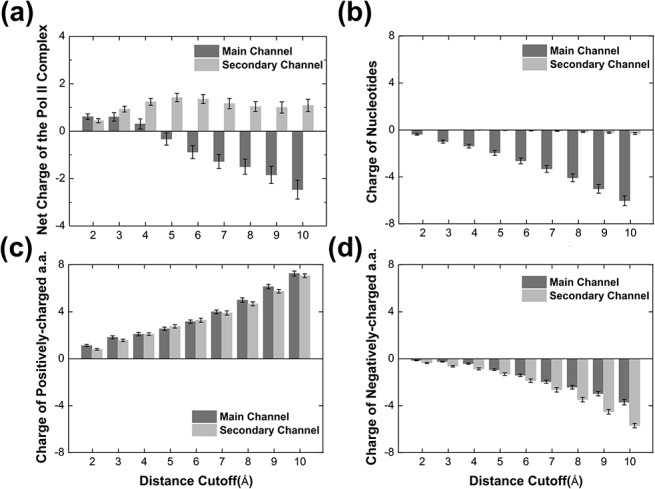
Distribution of charges surrounding the NTP during MD simulations.(a) The plot shows the net charge of the Pol II (protein and nucleotides, y-axis) within certain radius (x-axis) of the NTP in the diffusion pathways through the main channel (dark grey) or the secondary channel (light grey). (b)-(d) The same as in (a) but for the charges of the nucleotides, positively-charged amino acids (a.a.) and negatively-charged a.a. around NTP, respectively.